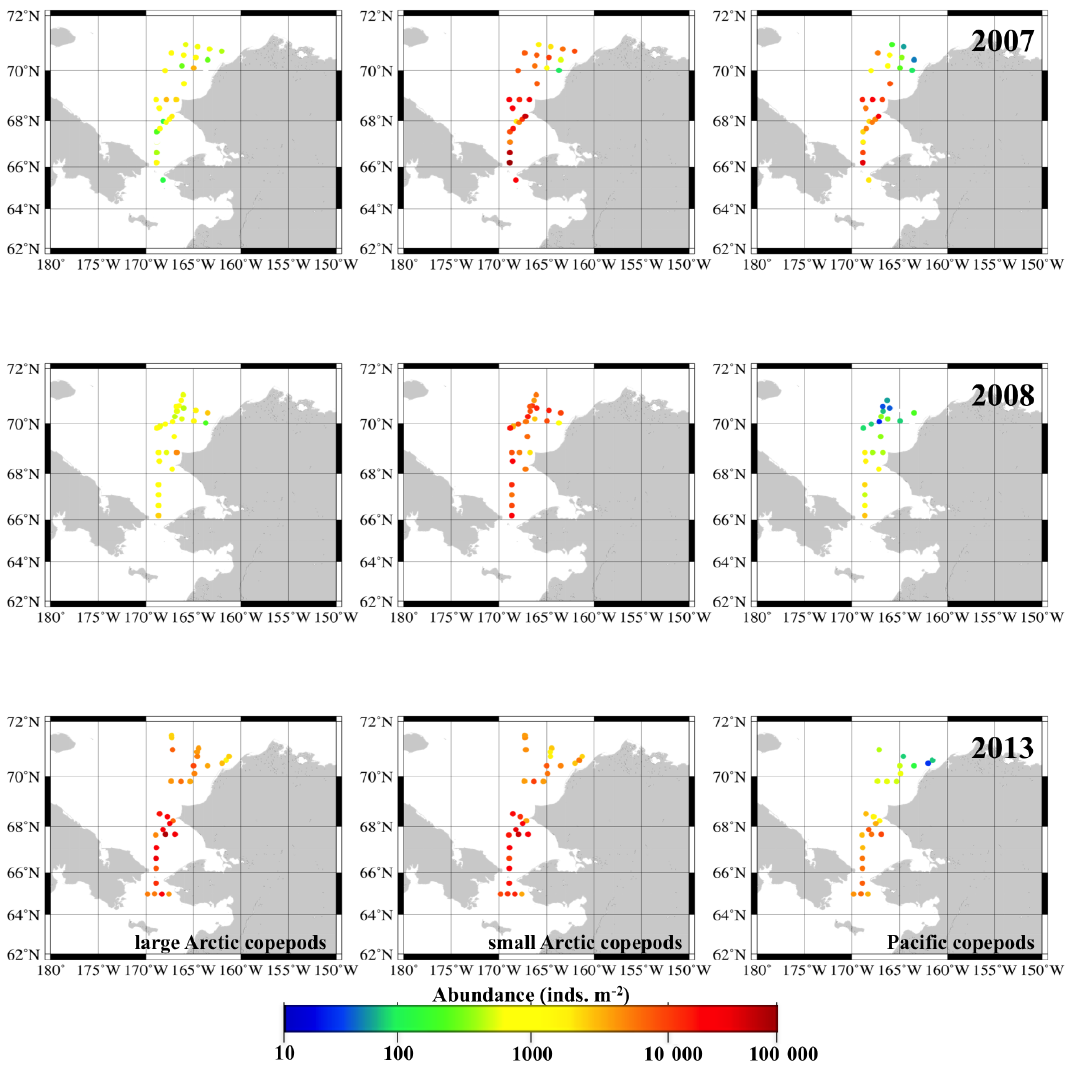
Figure 4. Distribution of copepods abundance in 2007, 2008 and 2013. large Arctic (CopL arc ) , small Arctic (CopS arc ) and Pacific (Cop pac )